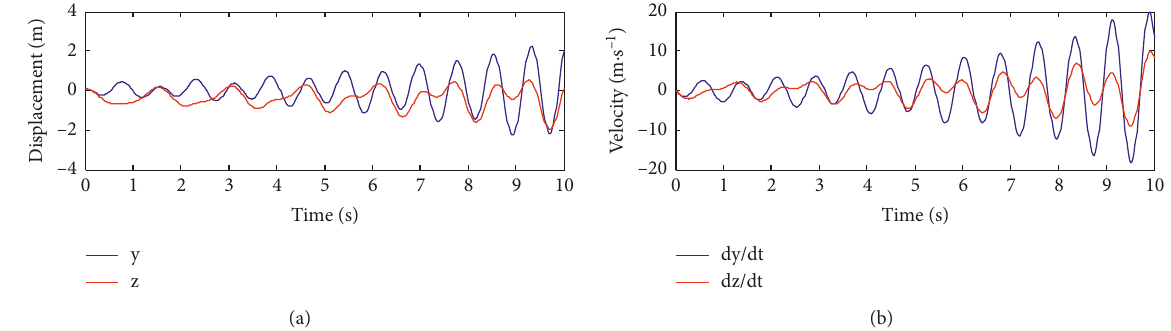
Figure 2: The uncontrolled divergent (a) displacements and (b) velocities of flap(z)/lead-lag(y)